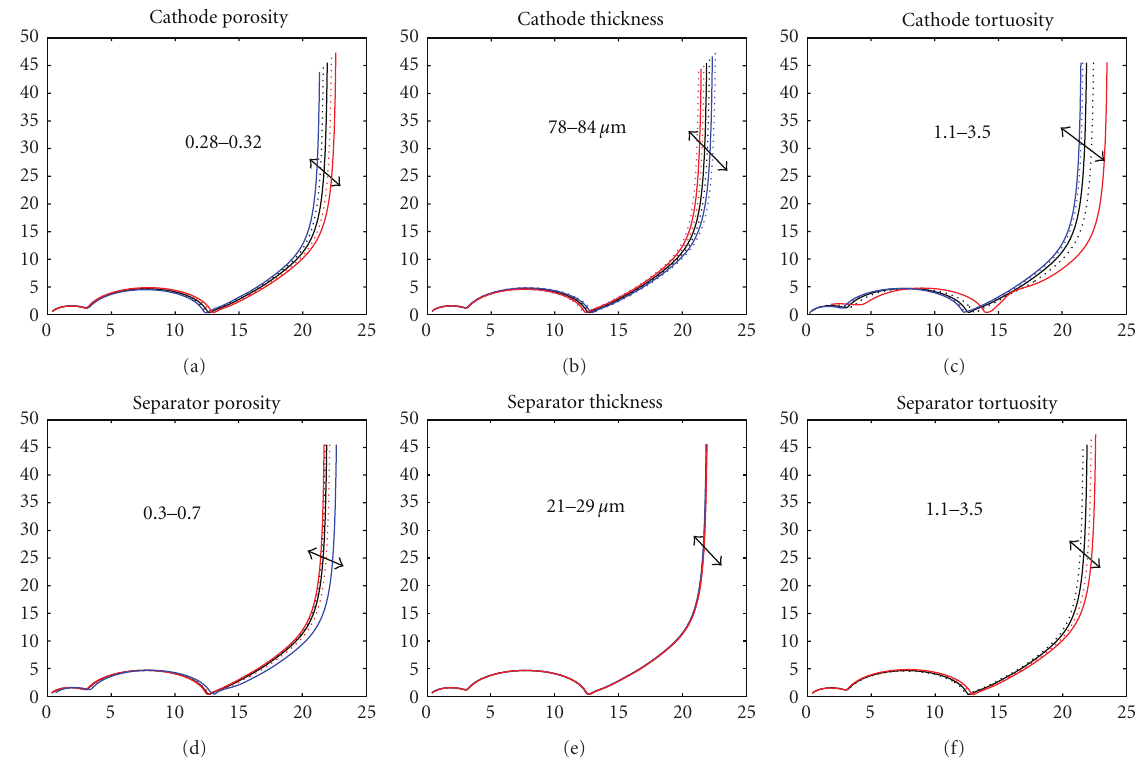
Figure 5: Comparison of the sensitivity of the cell impedance to the corresponding design parameters within the cathode versus the separator; for the choice of nominal parameters shown in Table 1, the variations on the separator do not impact the cell performance as much as those of the